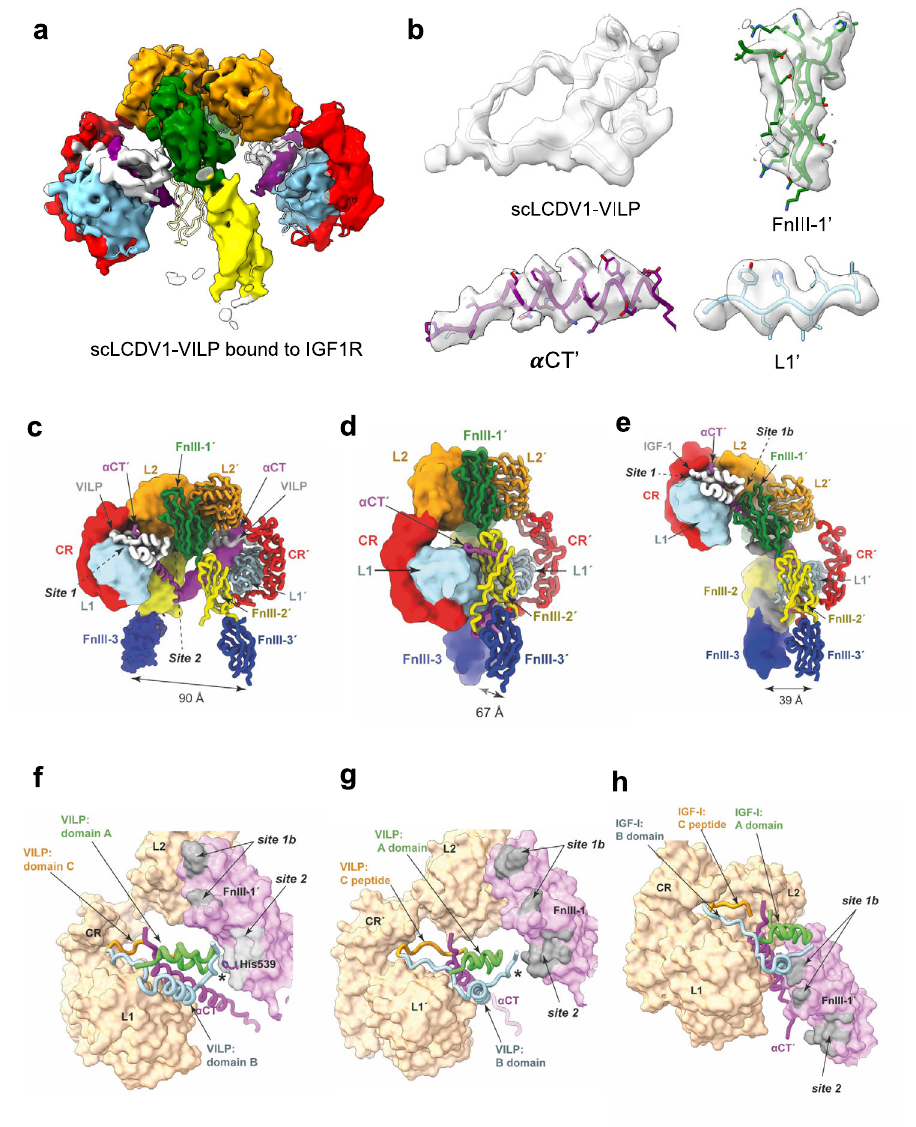
Fig. 5 | Relative conformations of the apo- and ligand-bound IGF1R ectodo- main.a CryoEMdensityplustheatomicmodelofscLCDV-1VILPboundtoIGF1R.zip shown in ribbon representation (map contour level 0.149). b CryoEM density associated with scLCDV1-VILP, domain FnIII-1 ′ , α CT´ and domain L1 (map contour level0.149). c CryoEMstructureofIGF1Rectodomainincomplexwithtwocopiesof